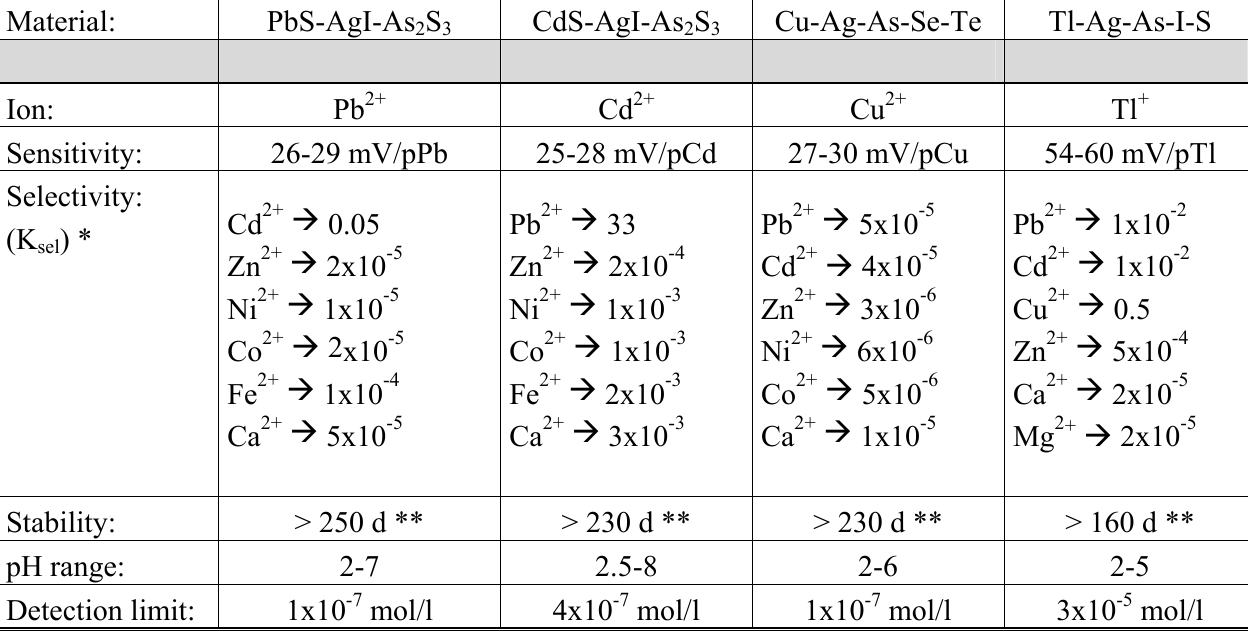
Table 1. Electrochemical parameters of the chalcogenide glass